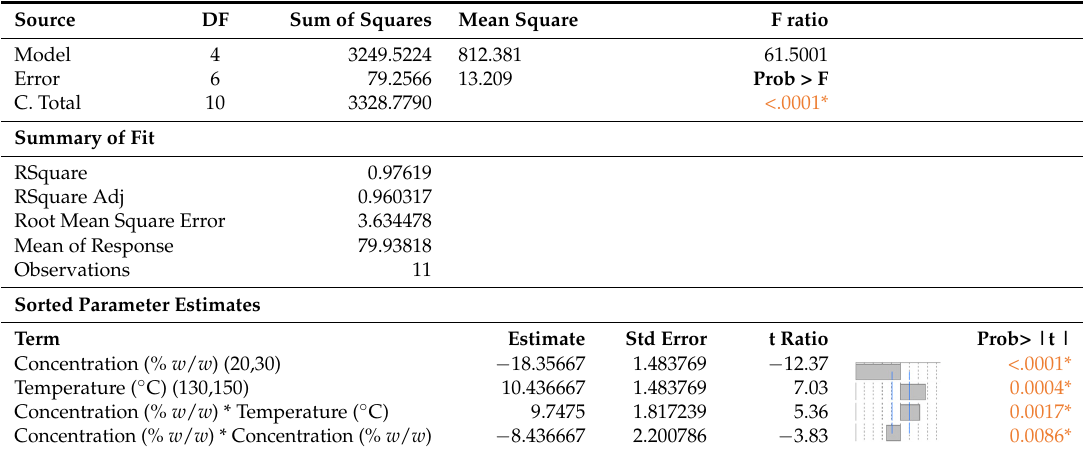
Table 6. Analysis of variance for response Abs at 680 nm (DoE2).